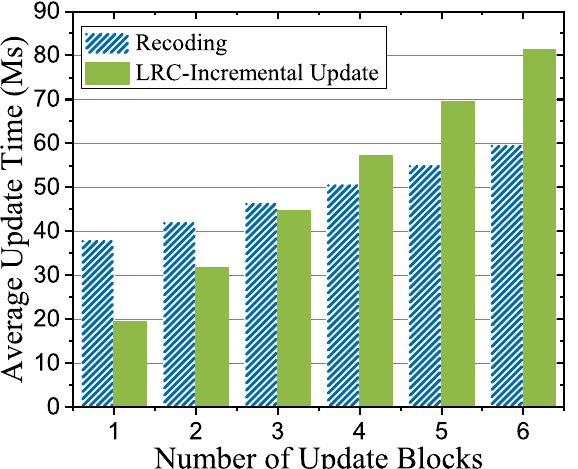
Figure 8. Cold tablets update performances based on locally repairable code (LRC)